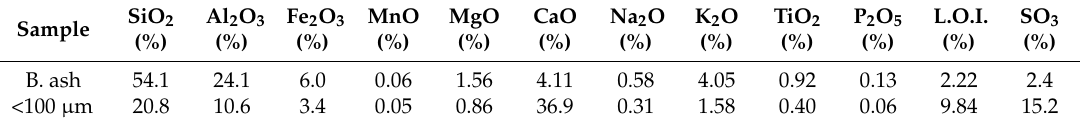
Table 1. Chemical composition of the Bottom ash and <100 µ m particle